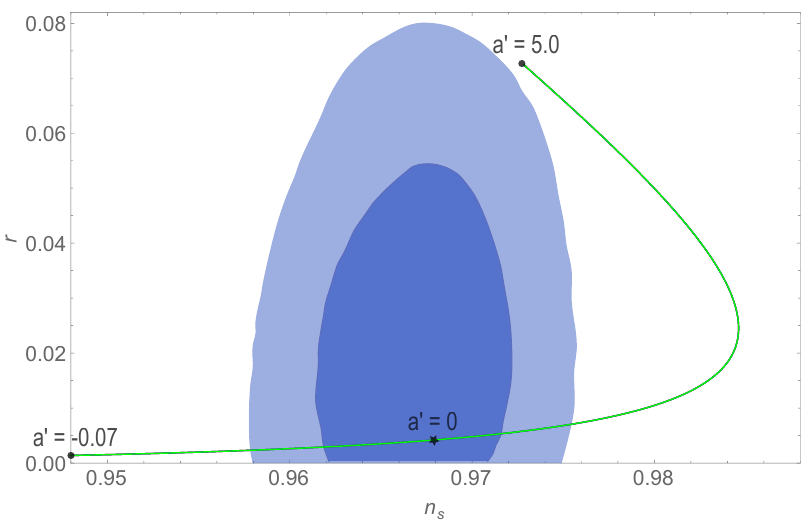
Figure 1 . n S vs r for ξ = 100 , 1000 and 5000 . From the inferior left extreme of the curve to its superior right, the parameter a 0 assumes the values − 0 . 07 ≤ a 0 ≤ 5 . The blue areas show the favoured regions by Planck2018, with 68% and 95% confidence level (Planck TT, TE, EE + lowE + lensing + BICEP 2 /Keck + BAO data set)